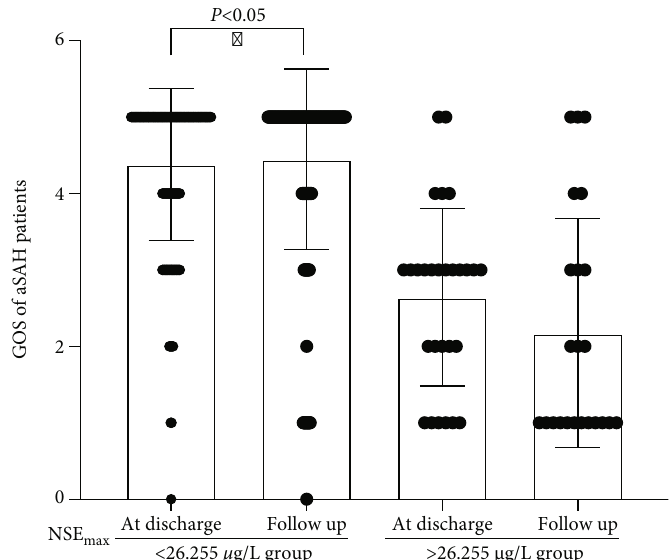
Figure 7: Change of GOS scores in two di ff erent groups at discharge and during follow